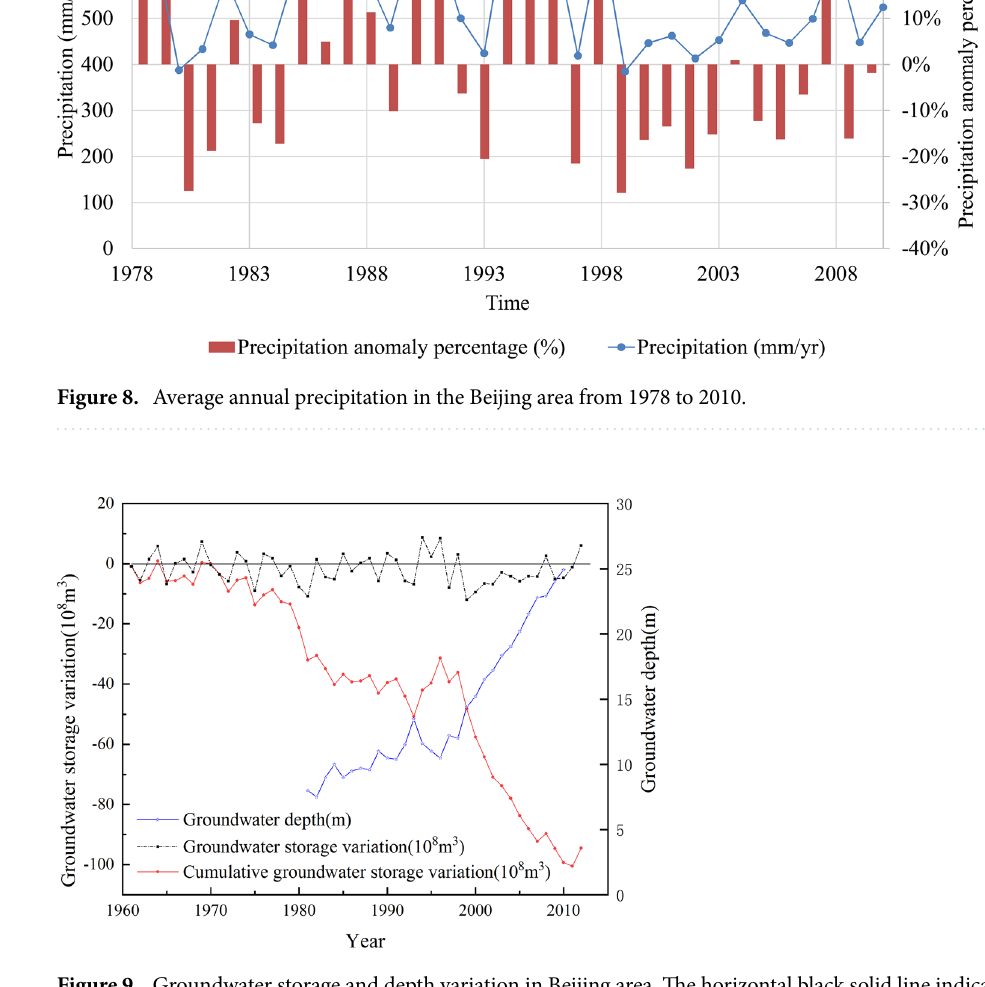
Figure 9. Groundwater storage and depth variation in Beijing area. The horizontal black solid line indicates that the groundwater storage variation is